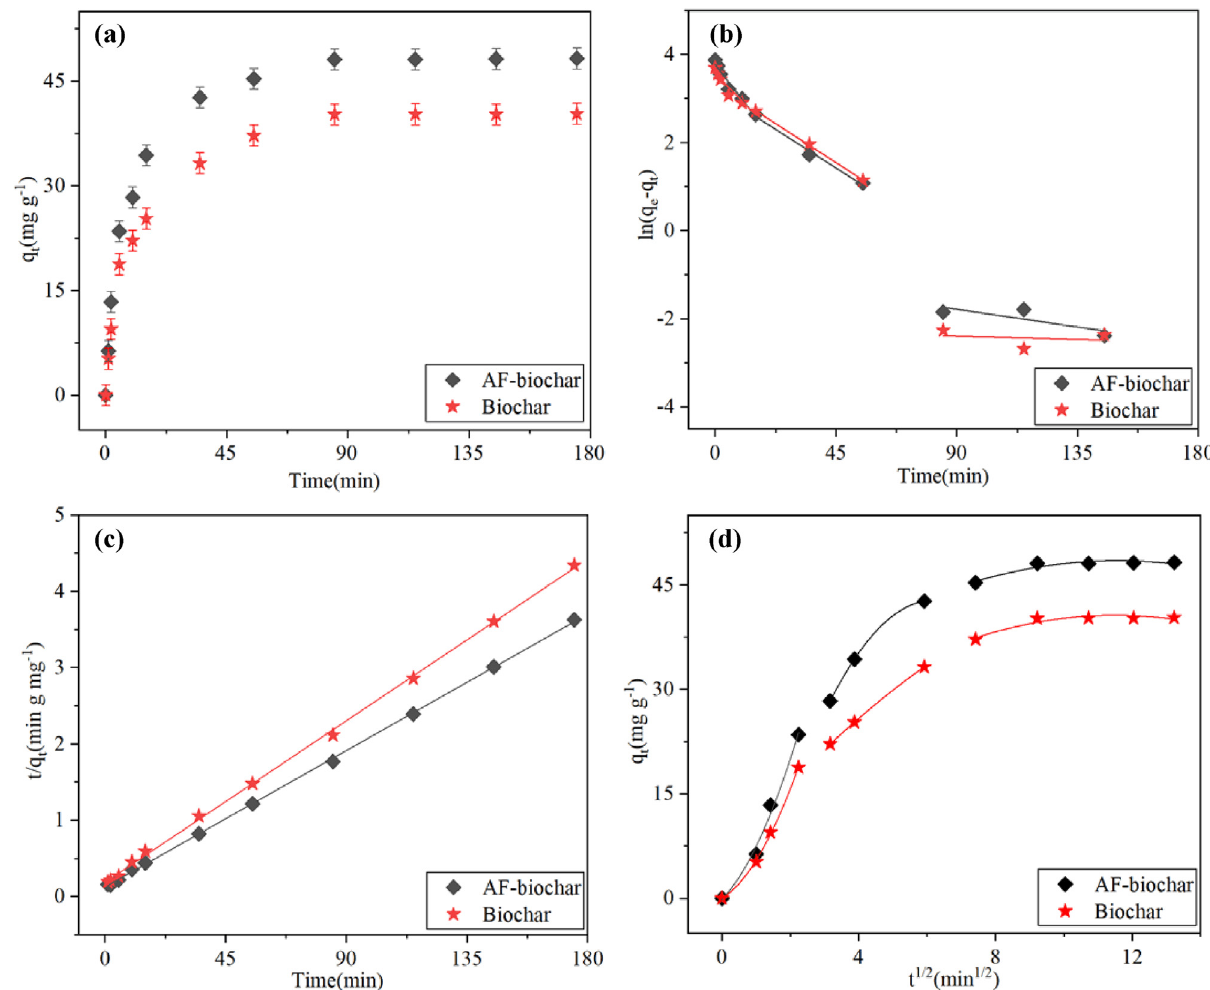
Figure 6: ( a ) E ff ect of contact time on adsorption of DAP by AF - biochar and Biochar ( experimental conditions: pH 4.8, initial concentration 25mgL − 1 , and temperature 298K ) ; ( b ) pseudo - fi rst order model plot; ( c ) pseudo - second order model plot; and ( d ) intraparticle di ff usion